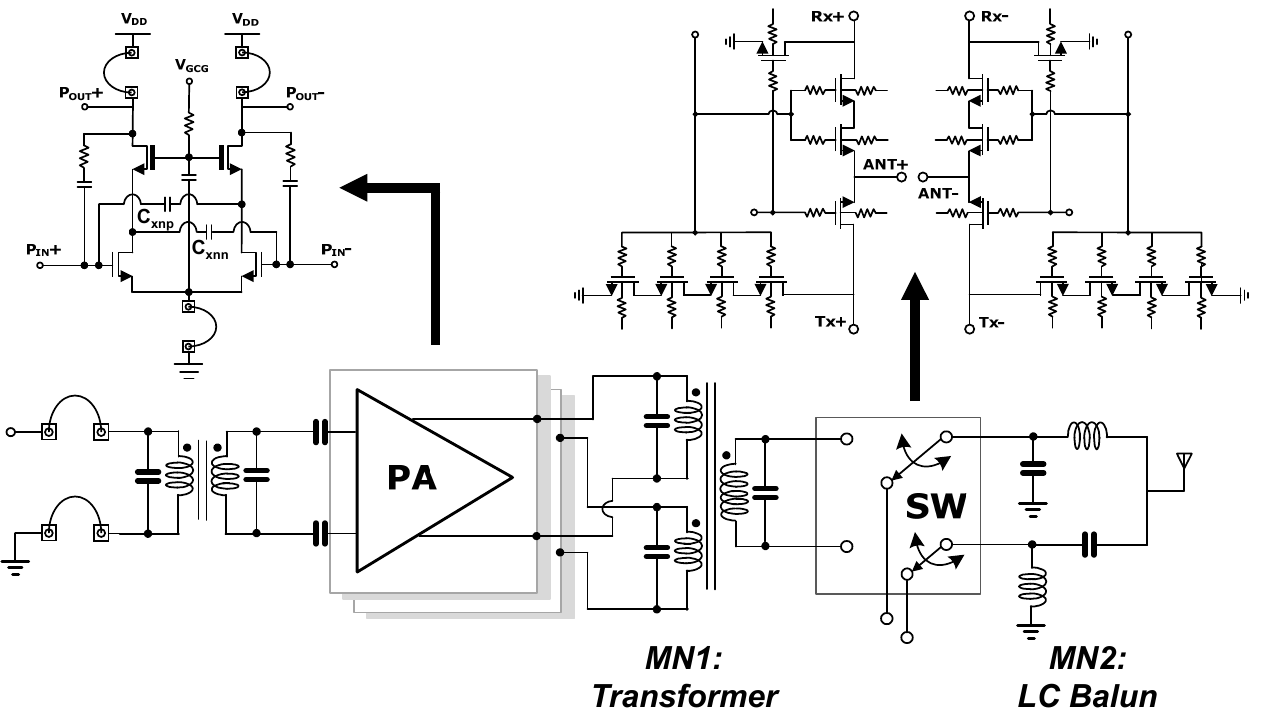
Figure 17. The schematic of the proposed fully integrated differential switch and power amplifier in CMOS technology.